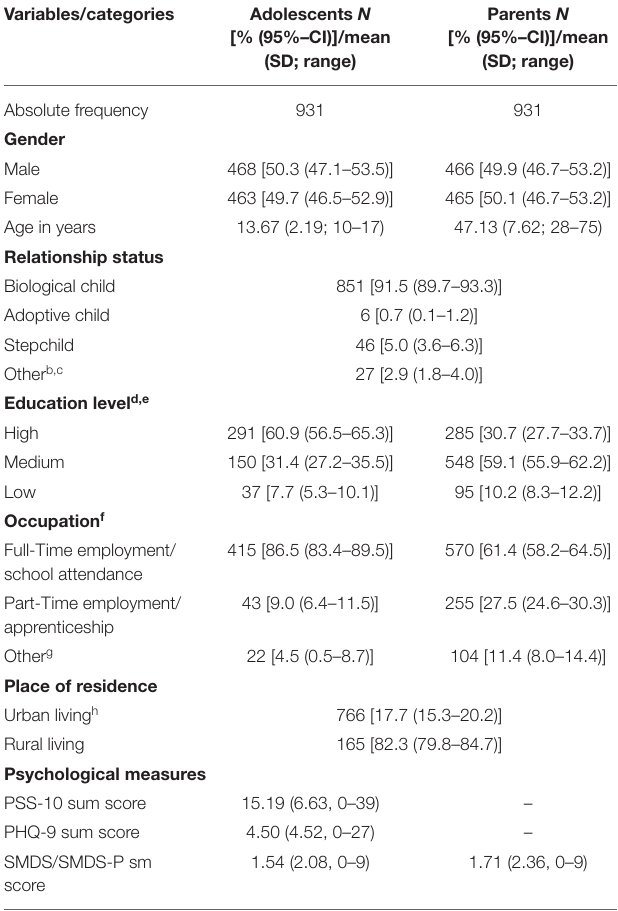
TABLE 2 | Characteristics of final sample parent-child dyads a